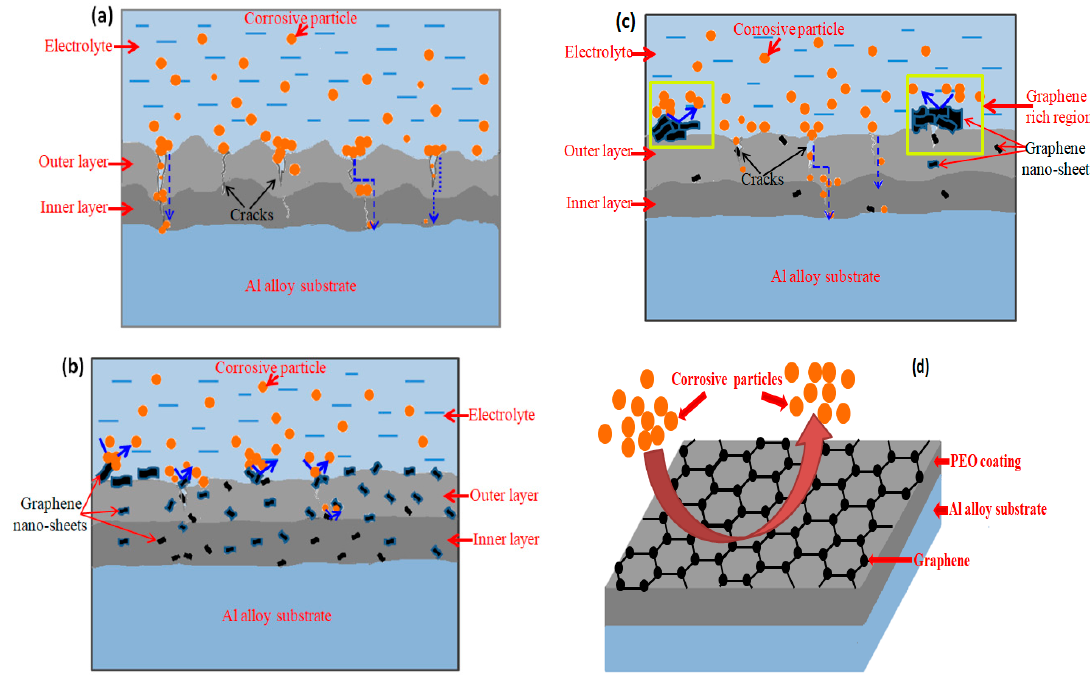
Figure 10. Schematic of the corrosion and protection mechanism of the coatings: ( a ) without graphene, ( b ) with graphene embedded in the coating, ( c ) with graphene spread on the surface of the coating, and ( d ) schematic of graphene as a chemically inert diffusion barrier.